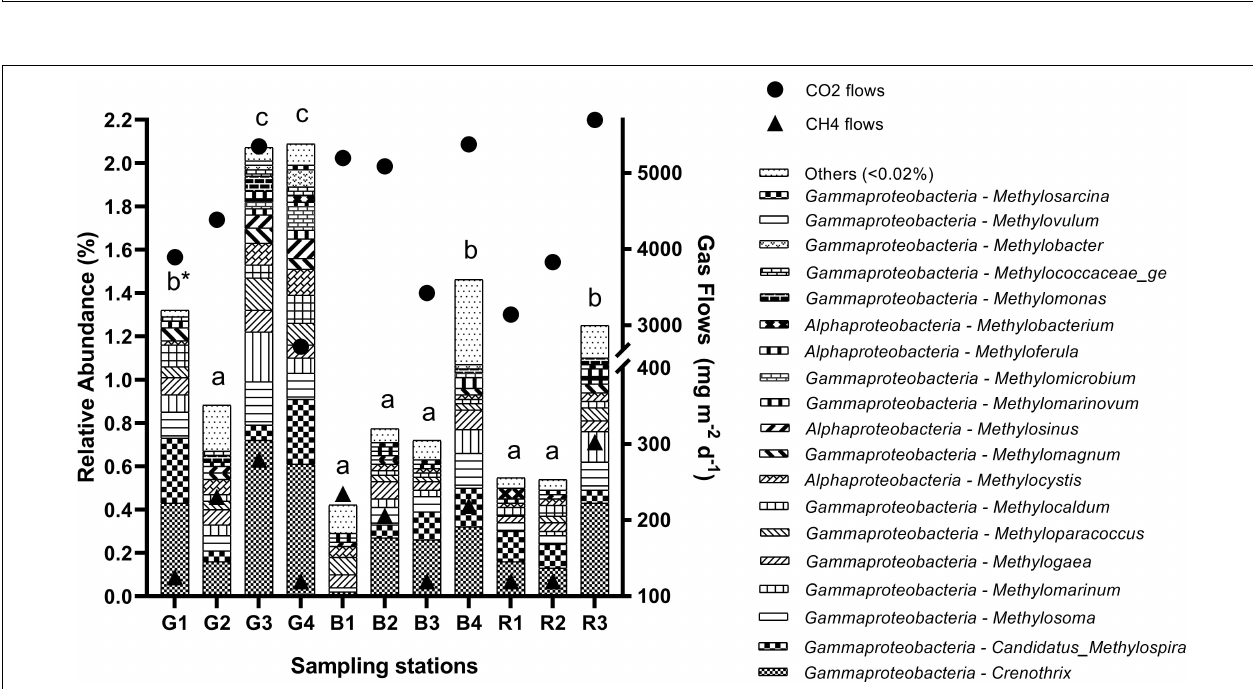
FIGURE 4 | Relative abundance of aerobic methanotrophic genera in the sediment of reservoirs and the atmospheric CO 2 and CH 4 flows throughout the seasons. “Others” refers to a group of genera with abundances lower than 0.02%. *Means with equal letters do not differ by the Scott–Knott test at 5% significance to methanotrophs abundance.